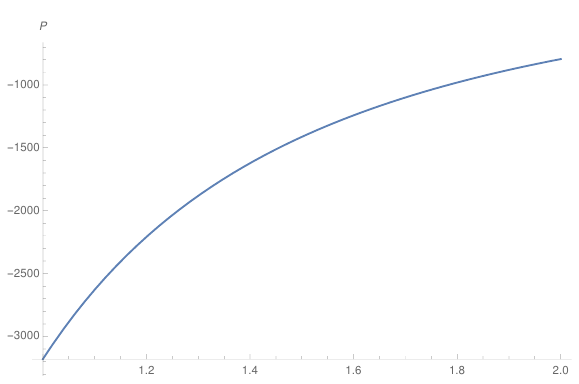
Figure 2. Plot of the Stix function P ( ω ) .